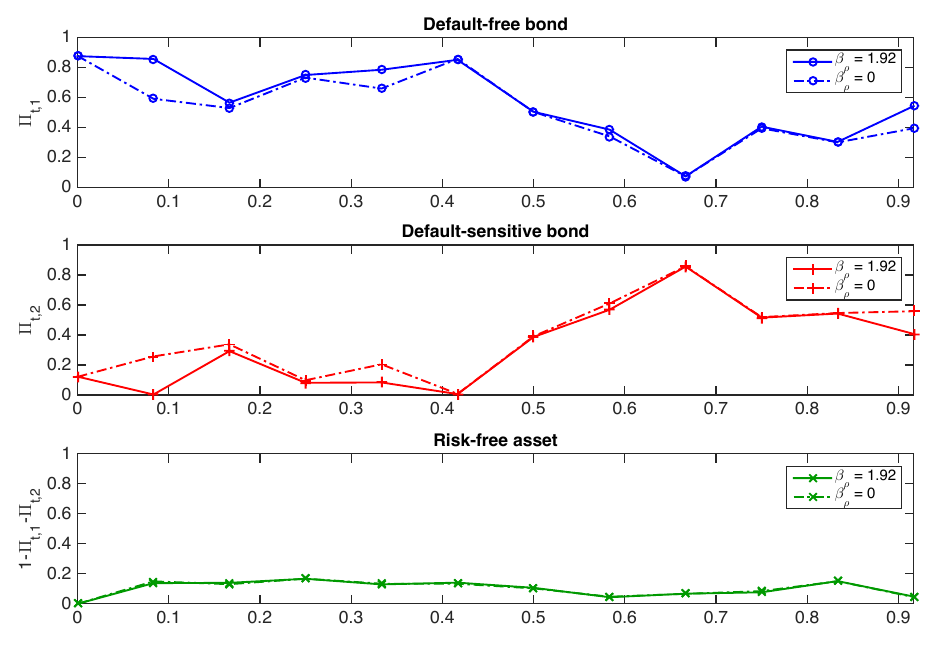
Figure A3. Sensitivity of optimal strategies to a change in β ρ .